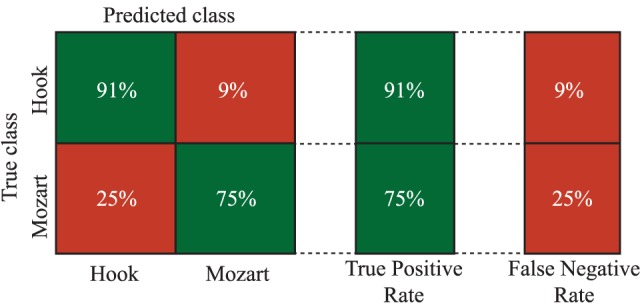
Confusion matrix.